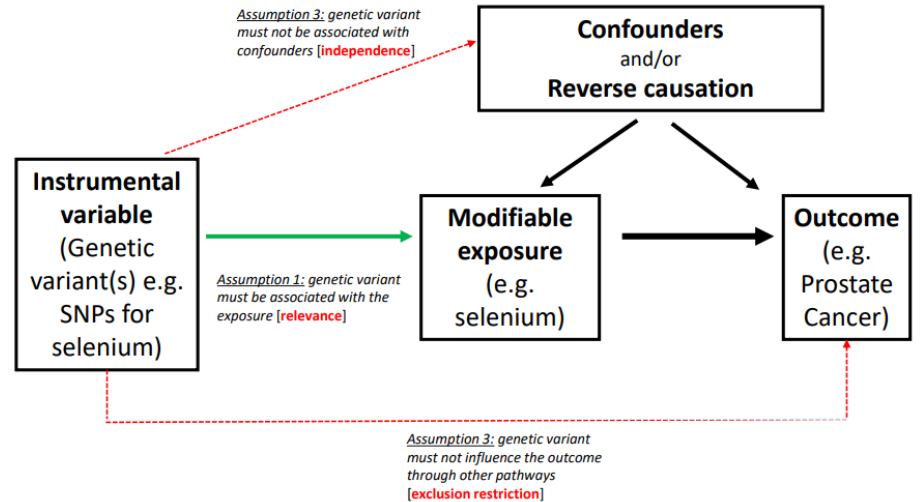
Figure 3. Illustration of the three key assumptions of Mendelian Randomization studies. This illustrates the relevance, independence and exclusion restriction assumptions of Mendelian Randomization with selenium as the modifiable nutritional exposure. The relevance assumption can be easily tested, and is considered as fulfilled if the SNP-exposure association has an F-statistic > 10. The independence assumption is hard to validate as problems due to pleiotropy and population substructure may occur but associations with known confounders should be null. In general, the exclusion restriction assumption is hard to validate as there may be pleiotropic effects of SNPs or SNPs in linkage disequilibrium correlated with genes that have effects on the outcome independently of the exposure. It is important to perform a variety of sensitivity analyses that make different assumptions about pleiotropy. Severe departure from any of these assumptions can lead to a biased estimate, leading to an unreliable causal